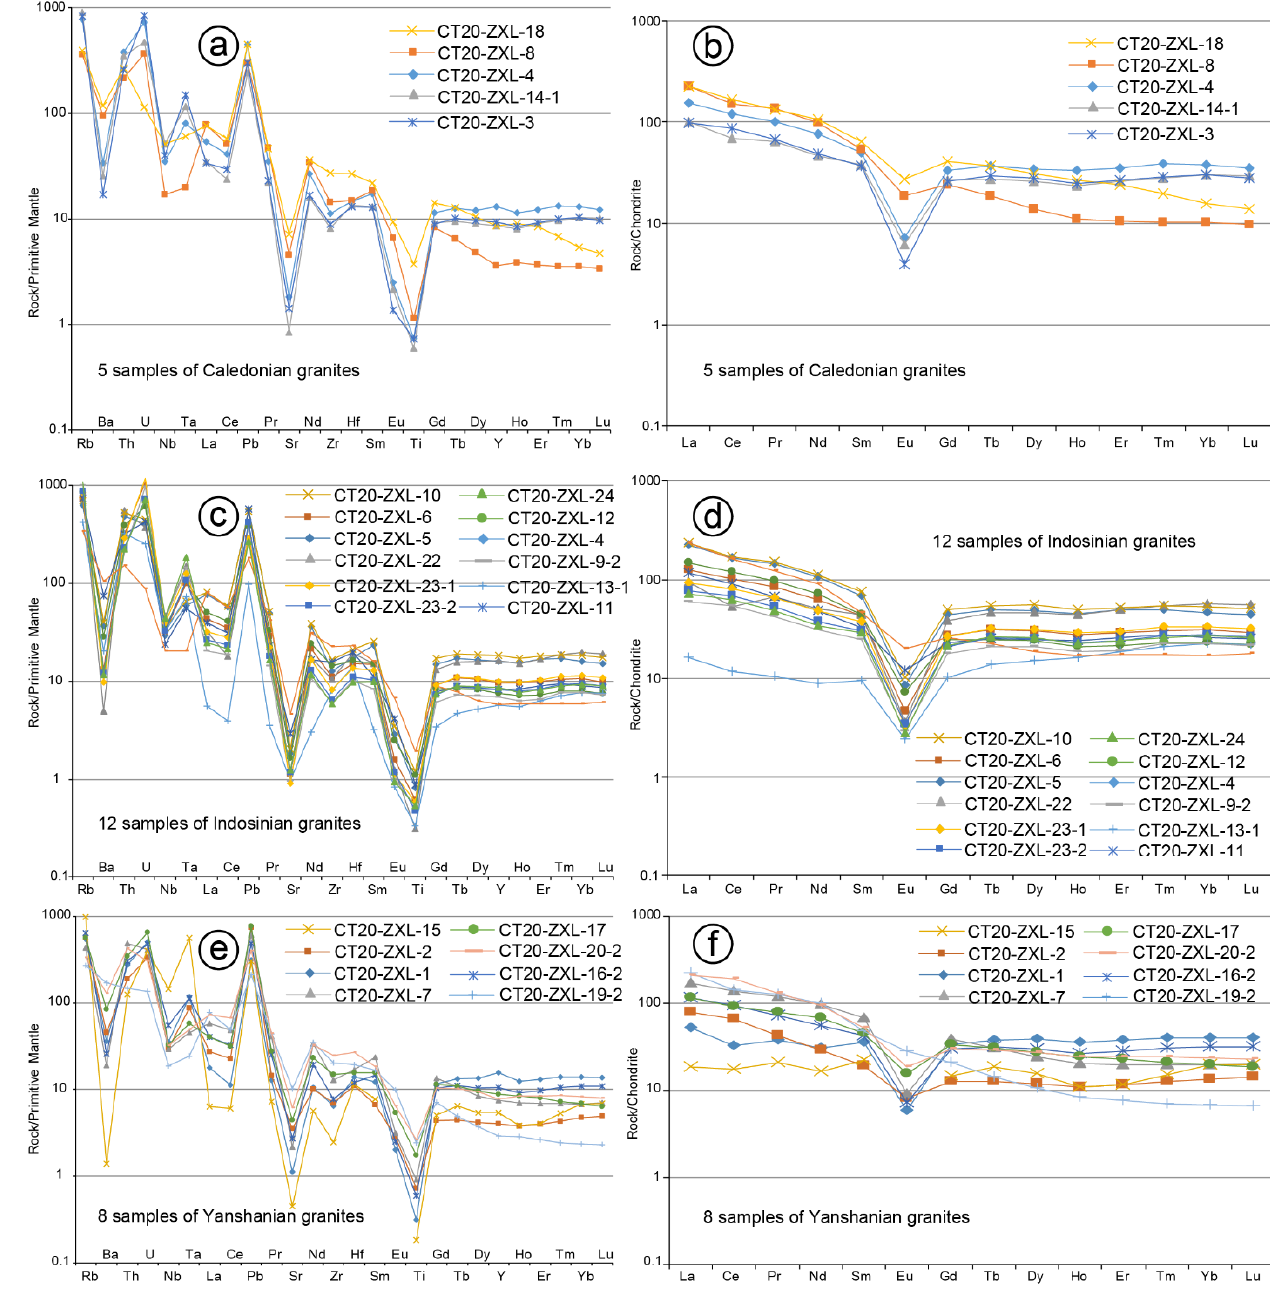
Figure 15. Primitive mantle-normalized trace element ( a , c , e ) and chondrite-normalized REE pattern ( b , d , f ) diagrams for the various granites form the Taoxi dome. The values of chondrite and primitive mantle are from Sun and McDonough (1989) [47].